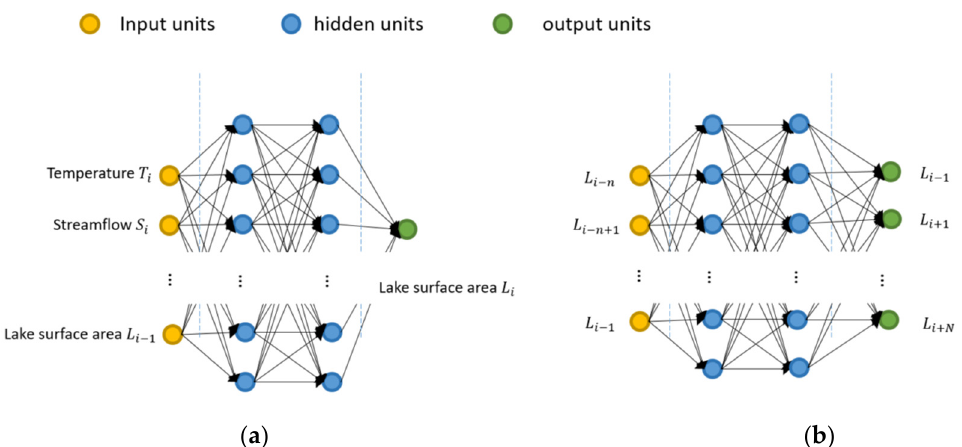
Figure 3. Overview of the topology of the two proposed MLP models. ( a ) is MLP model using extraneous factors and ( b ) MLP model using historical date of lake surface area. Table 1. Hyperparameters se tt ings of the proposed ANN models.